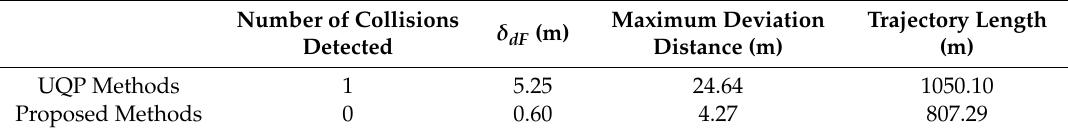
and the dotted line represents the average value of the deviation distance δ dF .